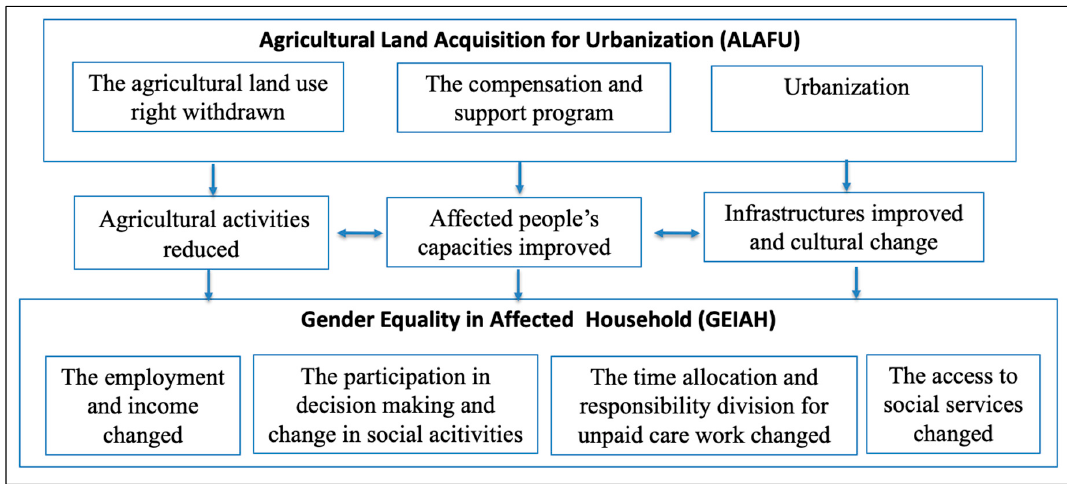
Figure 1. The linkage between Agriculturad Land Acquisition for Urbanization and Gender Equality in Affected Household.